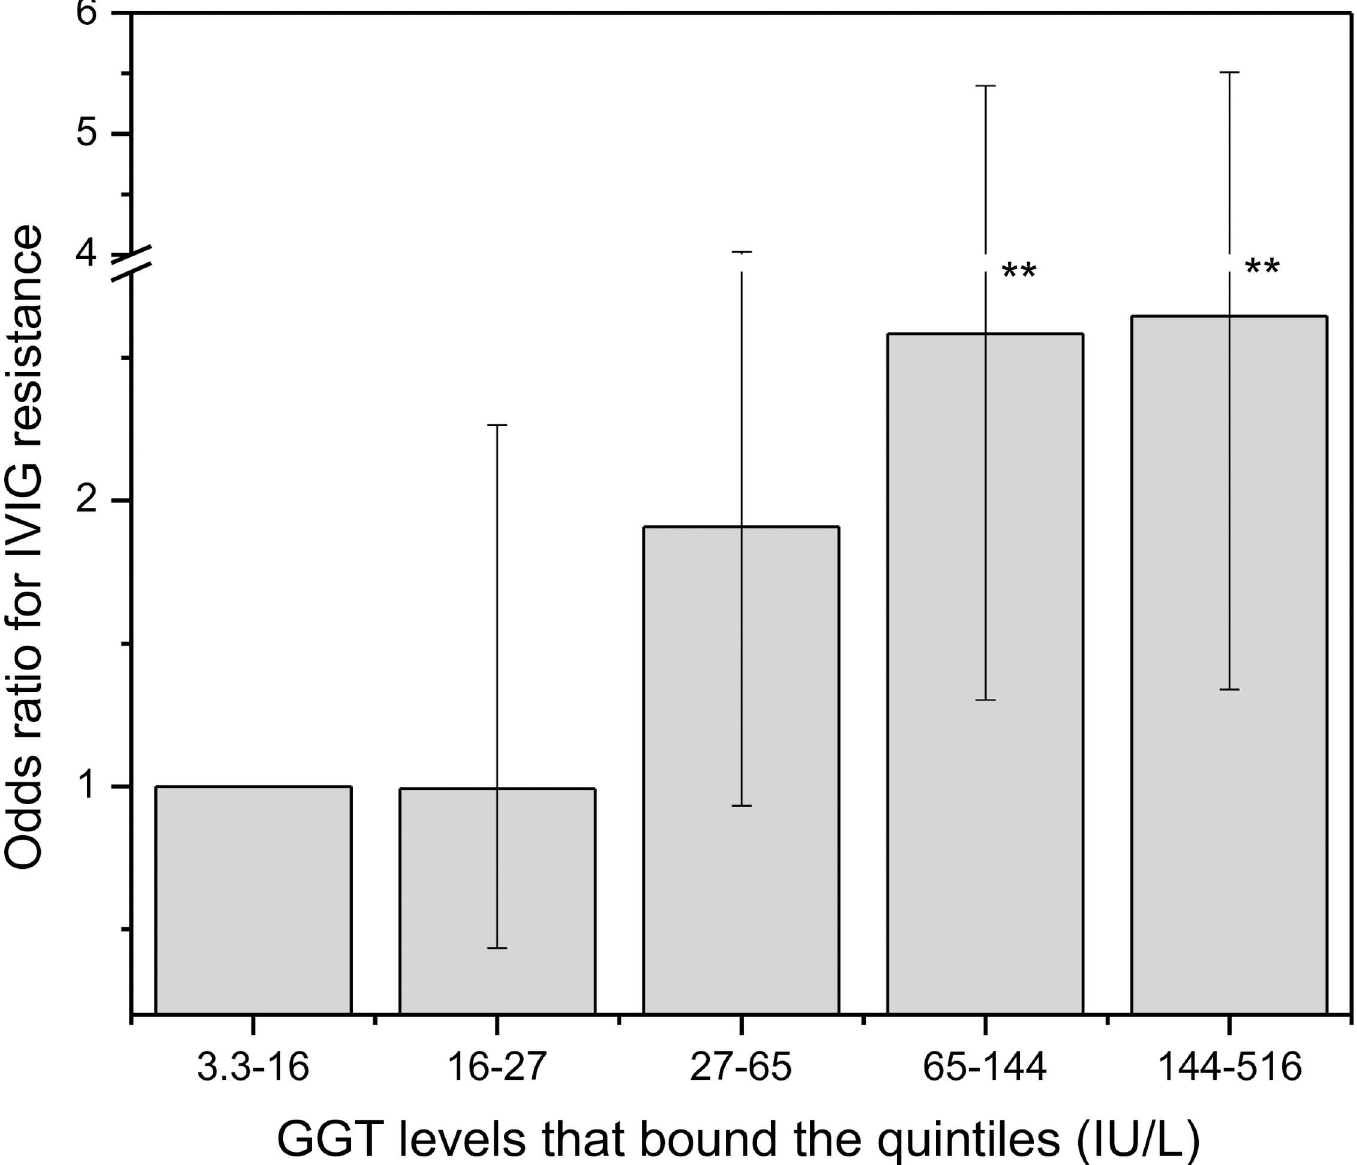
Fig 2. Odds ratio for IVIG resistance per quintile of GGT level. The odds ratios were calculatedagainstthe first quintilewith the lowest GGT level. The 95% confidential intervalswere shown as the error bars. ** : P value < 0.01 using fisher exact test. doi:10.1371/journal.pone.0167434.g002 PLOS ONE | DOI:10.1371/journal.pone.0167434 December21,